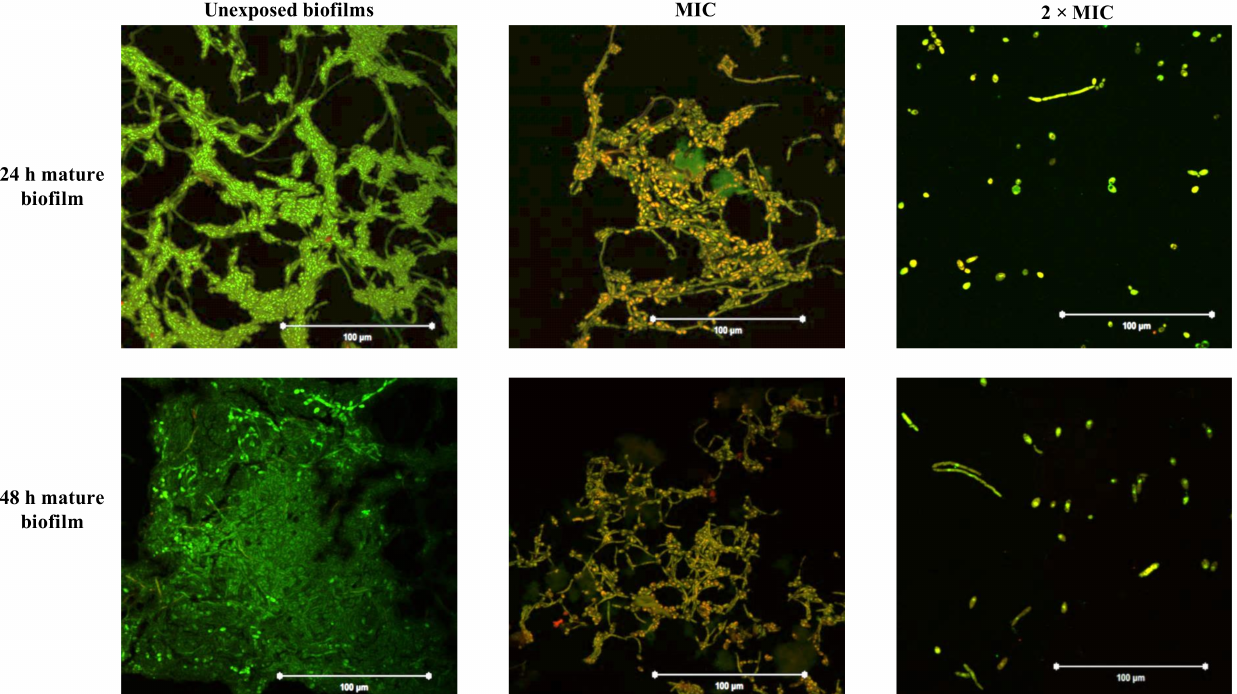
Figure 13. Inhibitory effect of Ag-Cu bimetallic NPs on mature C. albicans biofilms. The figure represents CLSM analysis of C. albicans SC5314 biofilms after exposure to test nanoparticles at various maturation phases (24 h and 48 h). The green fluoresces (Con A) represent the C. albicans cell wall and biofilm matrix; yellow-green fluoresces (FUN-1) represent dead/metabolically inactive